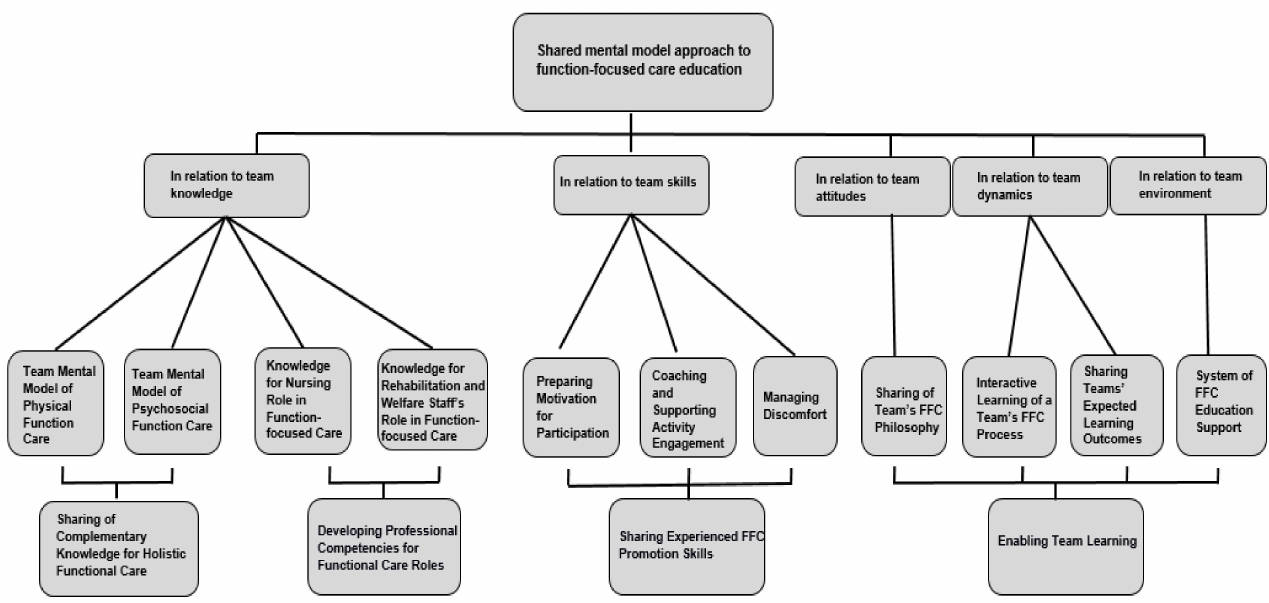
Figure 1. Coding tree for qualitative